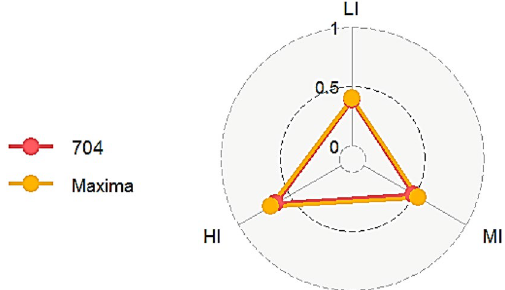
**, *, ns, respectively, significant at level of 1 and 5% and no significant. SOV: source of variance and df: degree of freedom. DM: dry matter, CP: crude protein, NDF: neutral detergent fiber, ADF: cell wall hemicellulose free, ADL: lignin, W.P.W: water productivity of wet forage yield, W.P.D: water productivity of dried fodder